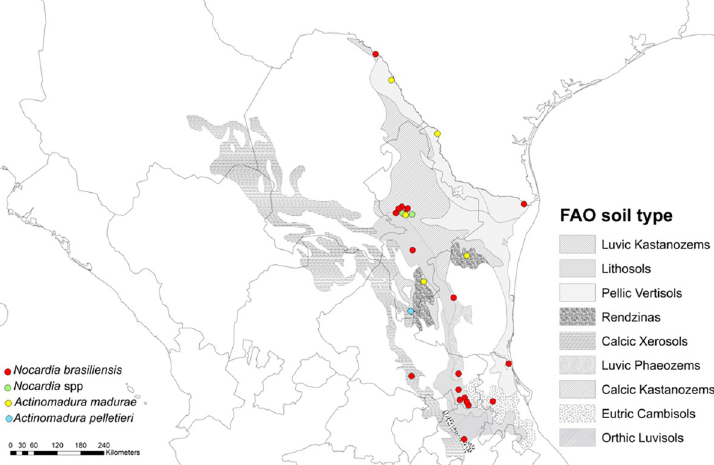
Fig 1. Map of actinomycetoma cases in Northeast Mexico. Figure was created for this publication using a shapefile from the Natural Earth database (naturalearthdata.com) and ArcMap of the ESRI (Environmental Systems Resource Institute) v. 10.5 (Redlands, California). Type of soils per FAO/UNESCO digital soil map of the world.